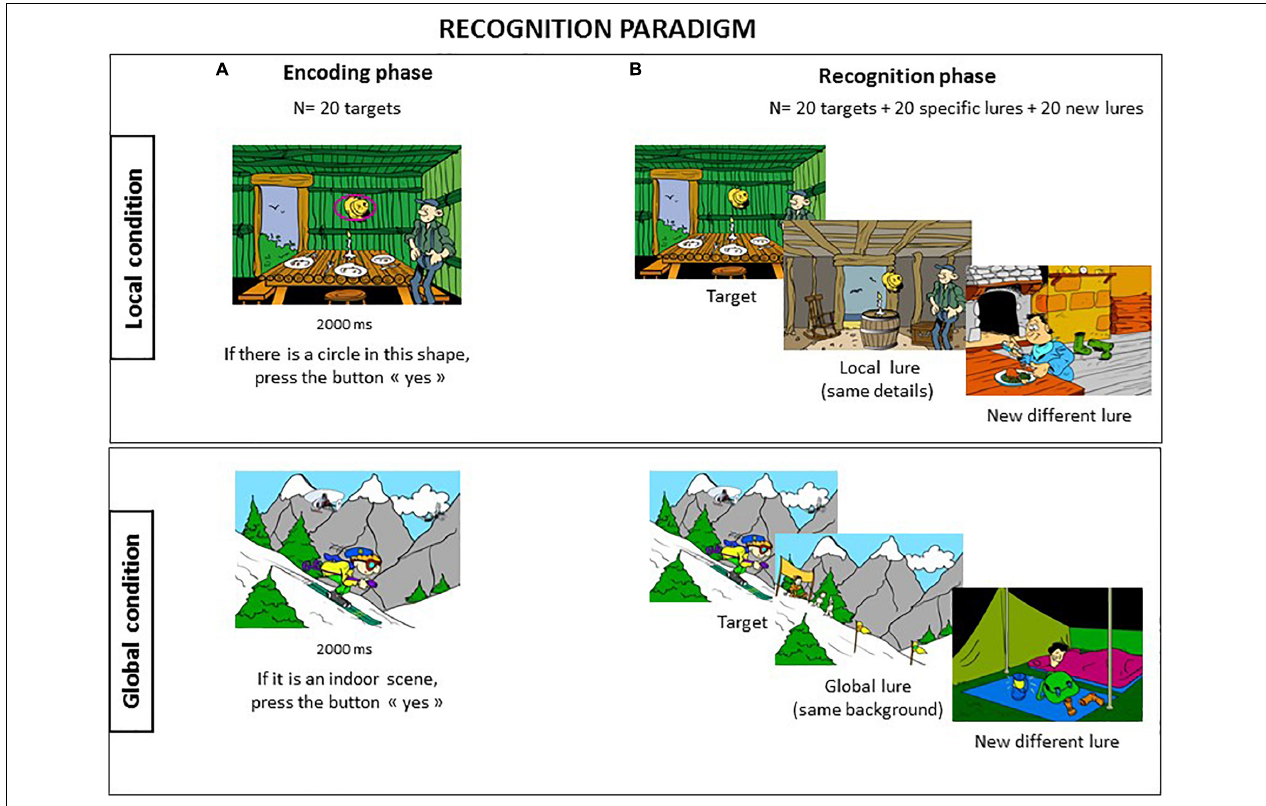
FIGURE 4 | Recognition paradigm. The recognition task was divided into two separate conditions [ (A) Local and (B) Global], provided in a counterbalanced order between subjects, and each involved an incident encoding phase followed after 10 min delay by a yes/no recognition